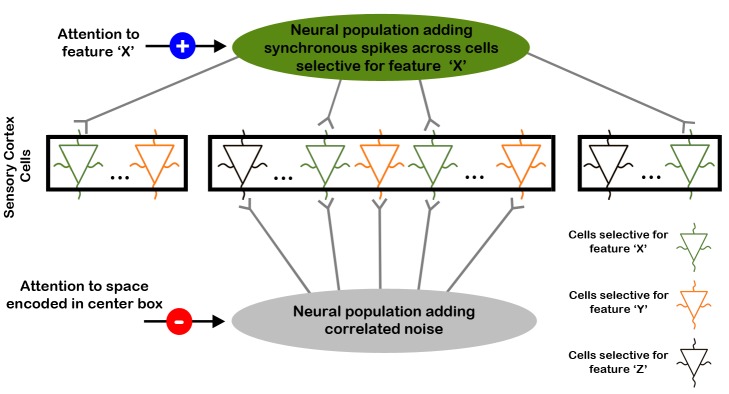
An attention model based on temporal correlation codes.The figure shows an illustration of a network model composed of three neural populations that aim to explain the attention effects on rsc and spike-synchrony observed in our study. The middle portion of the figure depicts a subset of cells in sensory cortex, which have selectivity to different stimulus features (depicted by their color) and different spatial or somatotopic RF properties (as shown by rectangles encasing them). The green ellipse represents a neural population that is selective for the same stimulus features as green neurons in sensory cortex (i.e., feature “X”). This neural population causes synchronous spikes in green colored sensory cells regardless of their spatial or somatotopic RF. The gray ellipse is a neural population that has the same spatial or somatotopic RF properties as neurons inside the center rectangle but it is not selective for a stimulus feature. This neural population is responsible for adding “correlated noise” between the neurons inside the center rectangle. The orange and black colored neurons are sensory cells selective for other types of stimulus features (i.e., not selective for feature “X”).